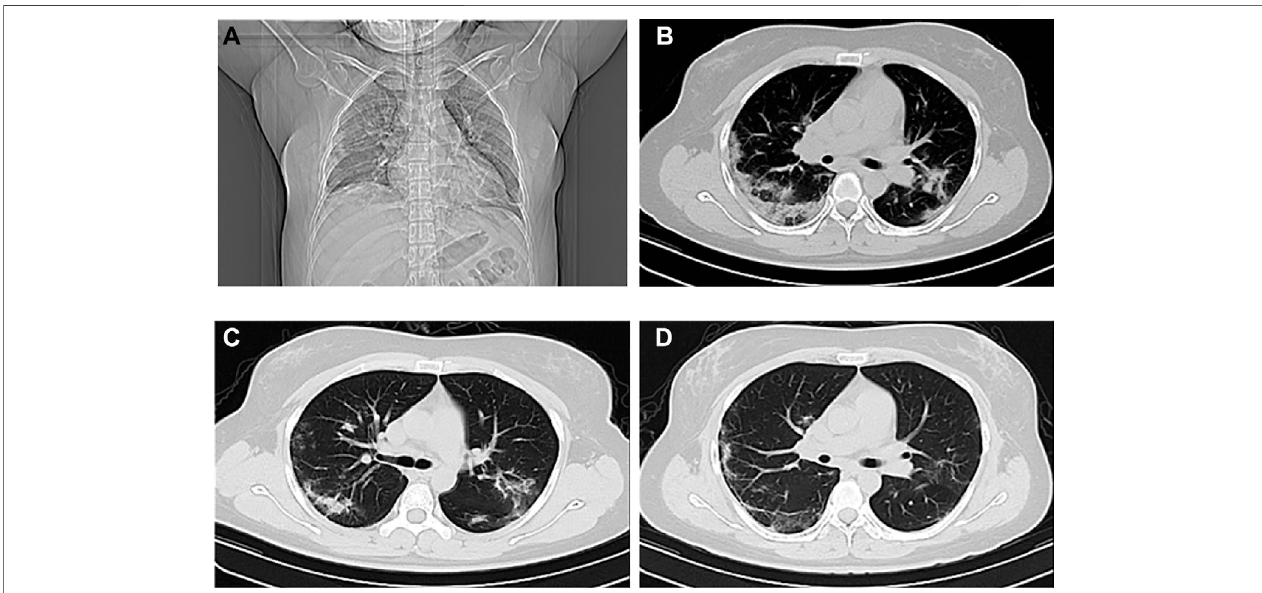
FIGURE 2 | Computed tomography images of the chest before and after treatment. A 45-year-old female who presented with bilateral pulmonary in fi ltrates at treatment initiation with YDJDG in coronal plane (A) and transverse plane (B) ; Marked absorption of bilateral pulmonary in fi ltrates at day 7 of YDJDG treatment (C) ; Dissipation of lesions at day 14 of YDJDG treatment (D) . YDJDG: Yindan Jiedu Granules.